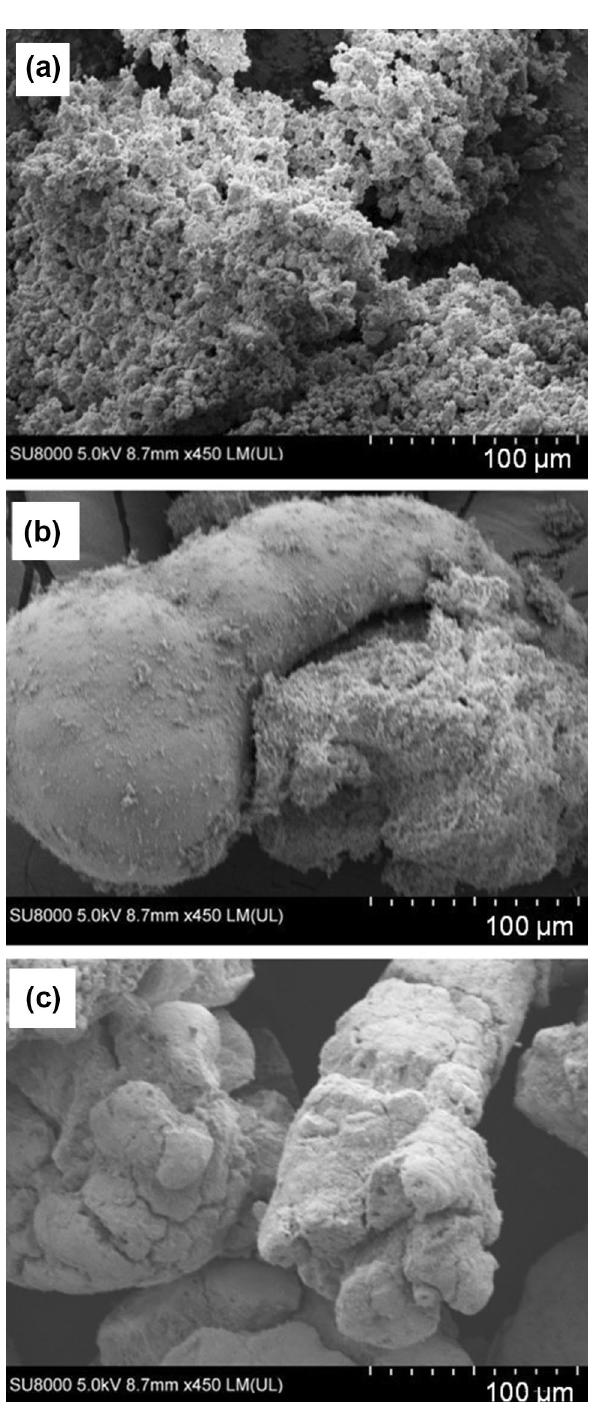
Fig. 5 SEM images of a pure boehmite and solid products from reac- tion using aluminum powder at b 250 °C for 24 h and c 300 °C for 1